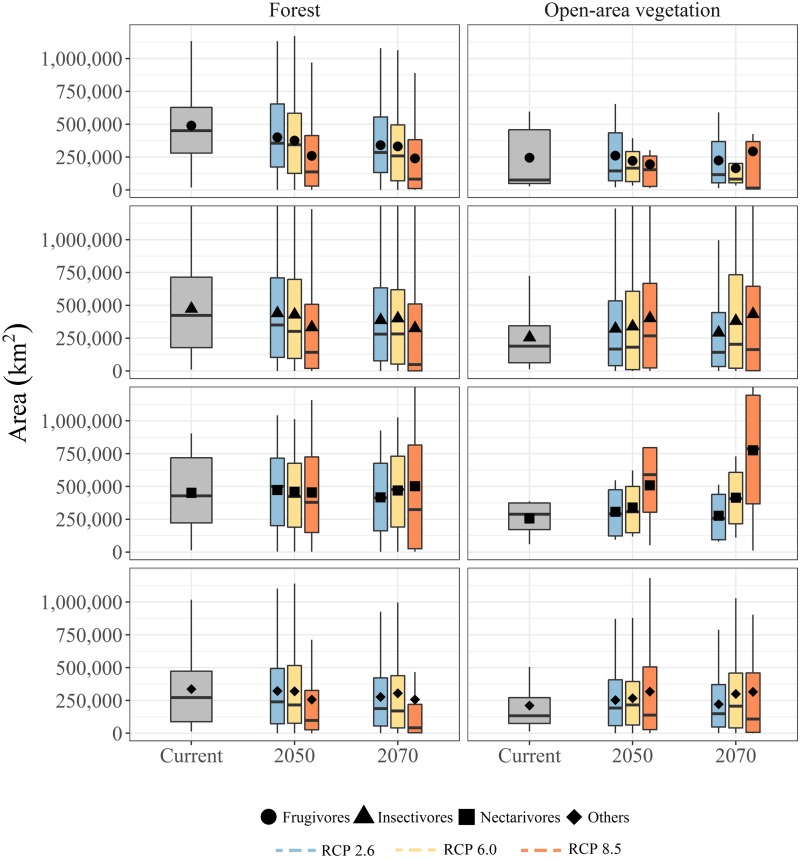
Potential change in mean area per trophic guild.Mean area for frugivores (circles), insectivores (triangles), nectarivores (squares), and other guilds (diamonds). Centre lines show the medians; box limits the 25%-75% percentiles in current (gray) and different future (2050 and 2070) climate change scenarios—RCP 2.6 (light blue), RCP 6.0 (orange), and RCP 8.5 (red); and whiskers 1.5x interquartile range of the data.